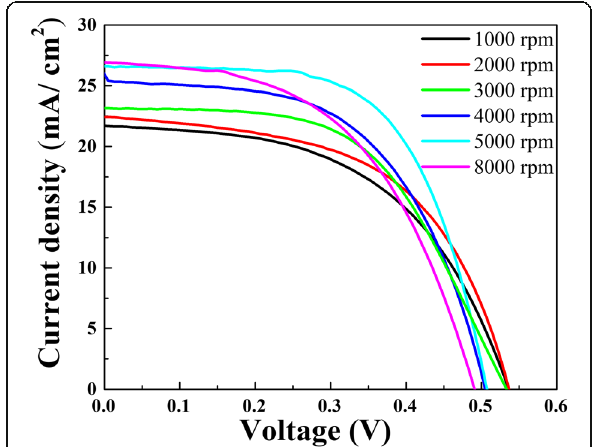
Fig. 7 The J-V curves of the HHSCs with different PEDOT:PSS coating rates from 1000 to 5000 rpm and 8000 rpm at AM1.5